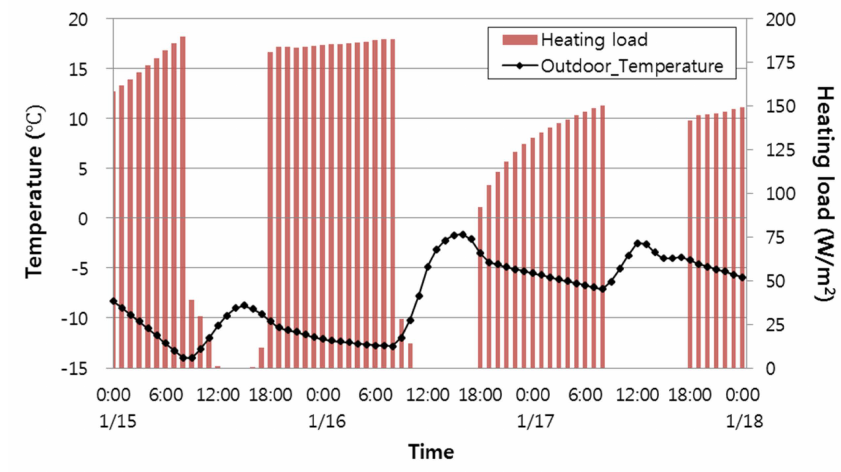
Figure 6. Simulation results of the representative three days in Dangjin.